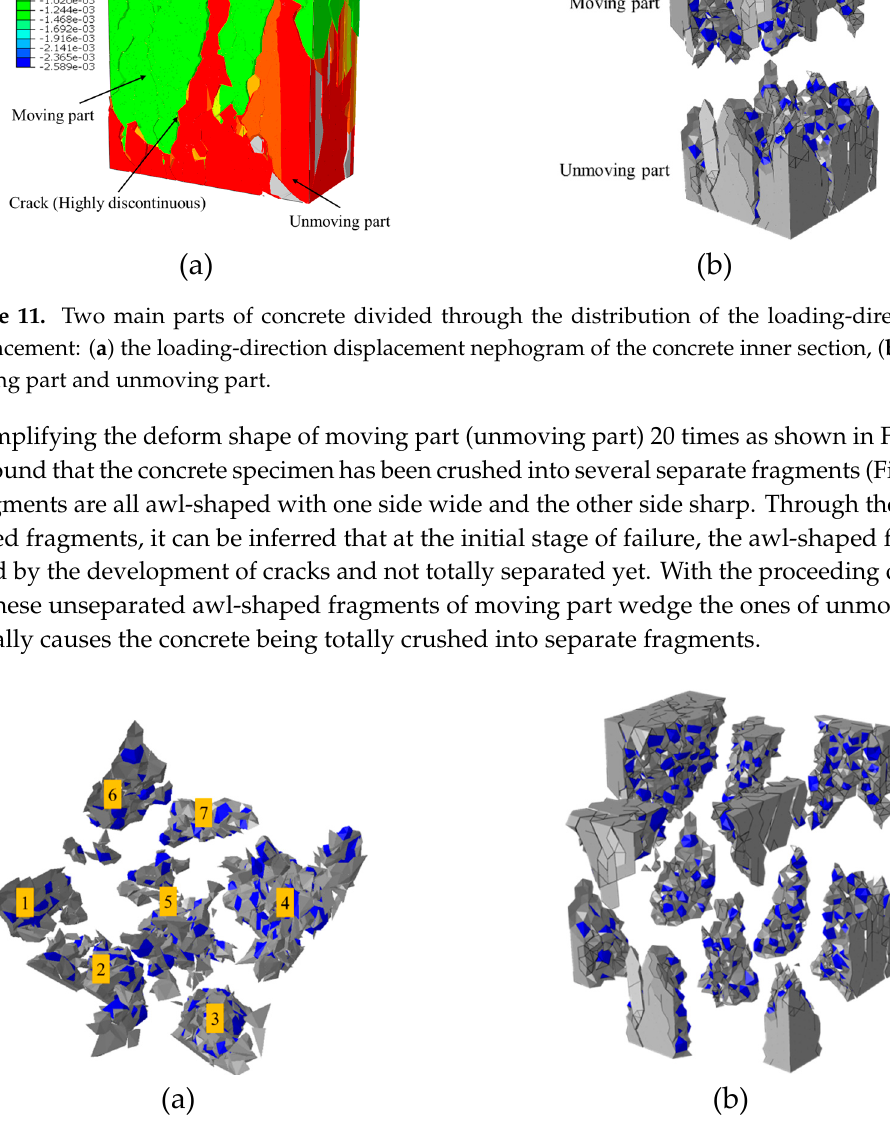
Figure 12. Fragments of the failure concrete specimen: ( a ) the deform shape of the unmoving part which is magnified 20 times, ( b ) the separated fragments of specimen.